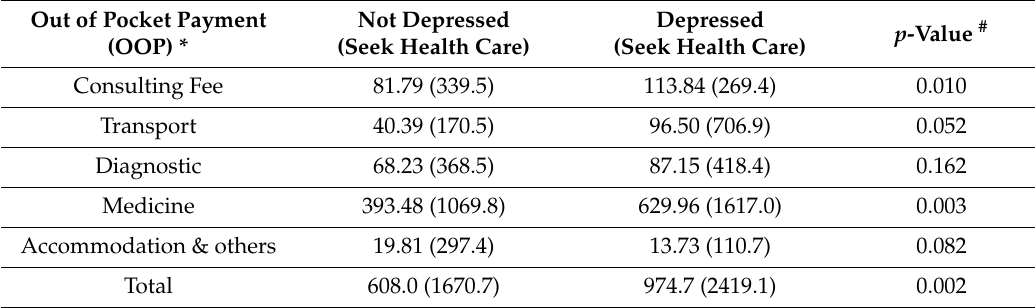
Table 4. Distribution of out of pocket (OOP) payment (mean, SD) of the families in last one month by depression status ( n = 449).